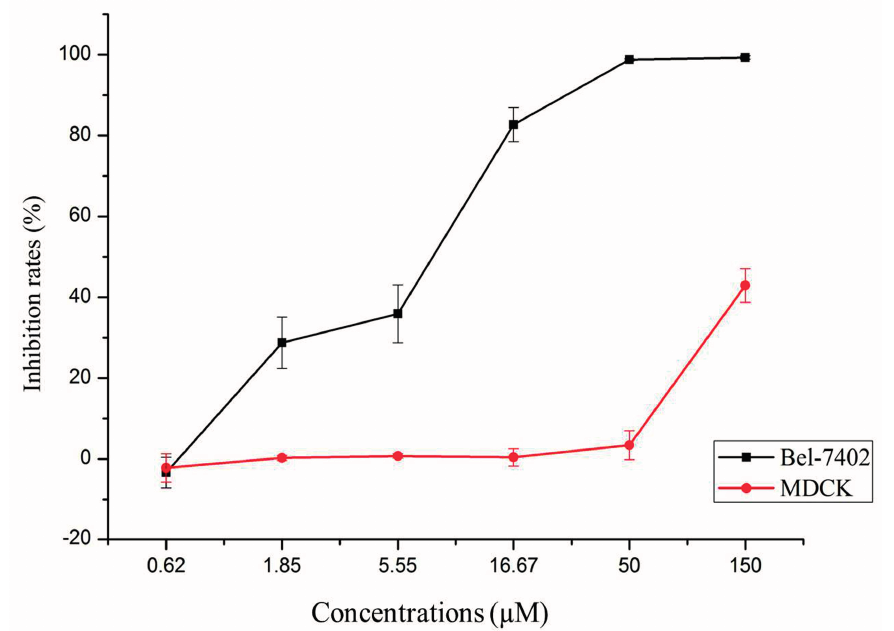
Figure 2. Selective cytotoxicity of T-OA on Bel-7402 and MDCK cell